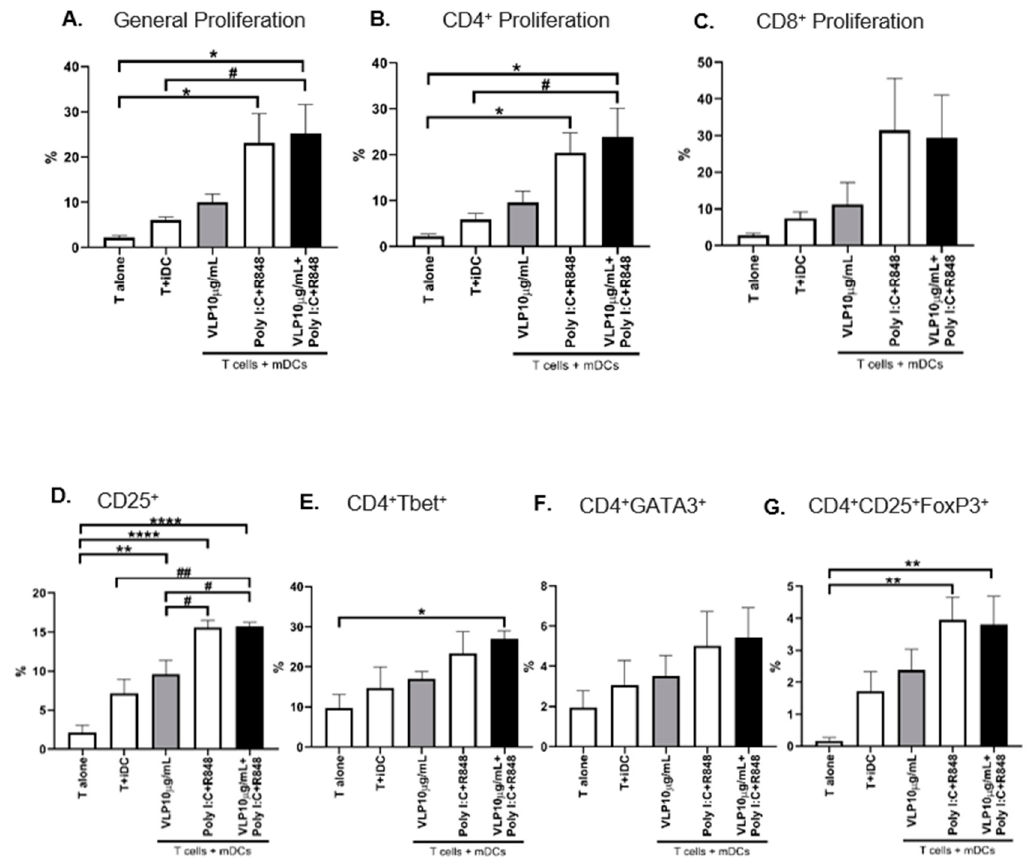
Figure 5. Functional capacities of the stimulated DCs. DCs were stimulated for 24 h with the indicated stimuli and then co-cultured with autologous T cells in a 1:10 ratio. The proliferation of T cells was determined after five days of co-culture by analysing the percentage of the total ( A ) general, ( B ) CD4 + , and ( C ) CD8 + T and cells that presented a decrease in CFSE fluorescence. The percentage of T cell activation was assessed using the expression of the cell marker ( D ) CD25 + . The polarization of T cells toward ( E ) Th1 (CD4 + Tbet + ), ( F ) Th2 (CD4 + GATA3 + ), and ( G ) “natural” Treg (CD4 + CD25 + FoxP3 + ) induced by DCs was evaluated using flow cytometry. The results are expressed as the percentage of cells within T lymphocytes. Each column represents the mean ± SEM of at least three independent experiments. * p < 0.05; ** p < 0.01, **** p < 0.0001 relative to the condition T alone; # p < 0.05, ## p < 0.01 among the other comparisons. iDC: immature DCs, mDCs: mature DCs, VLP: virus-like particles, PolyI:C: polyinosinic:polycytidylic acid, R848: